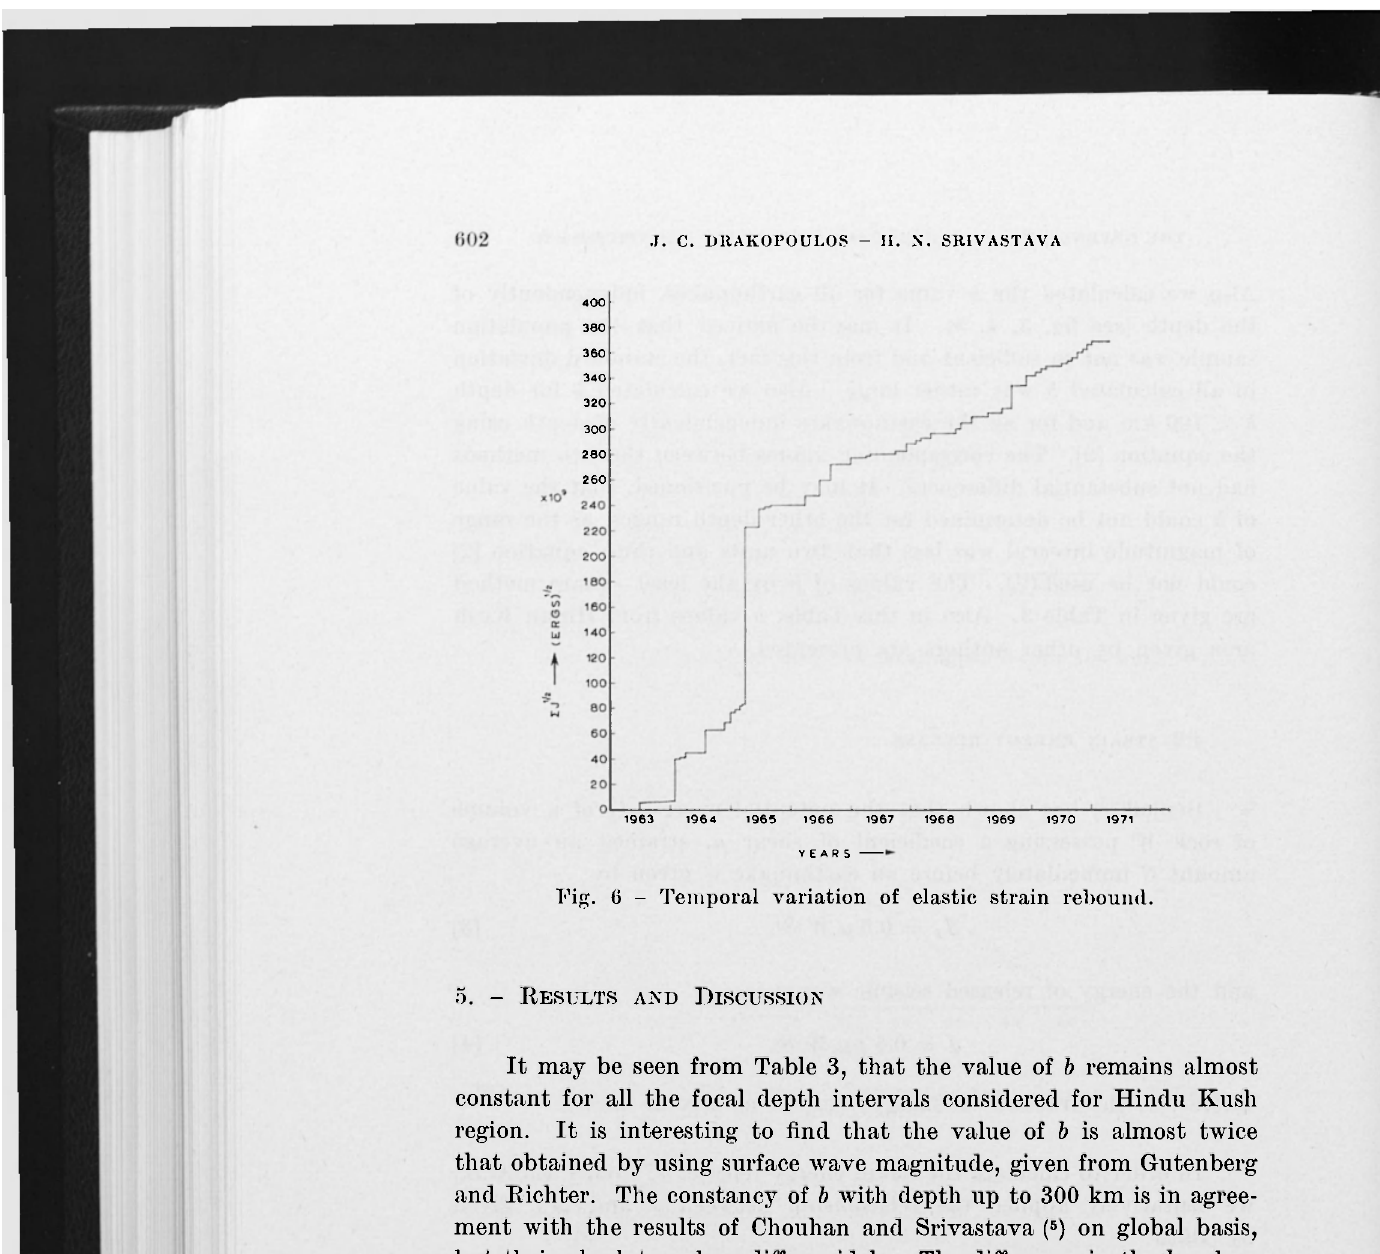
Fig. 6 - Temporal variation of elastic strain